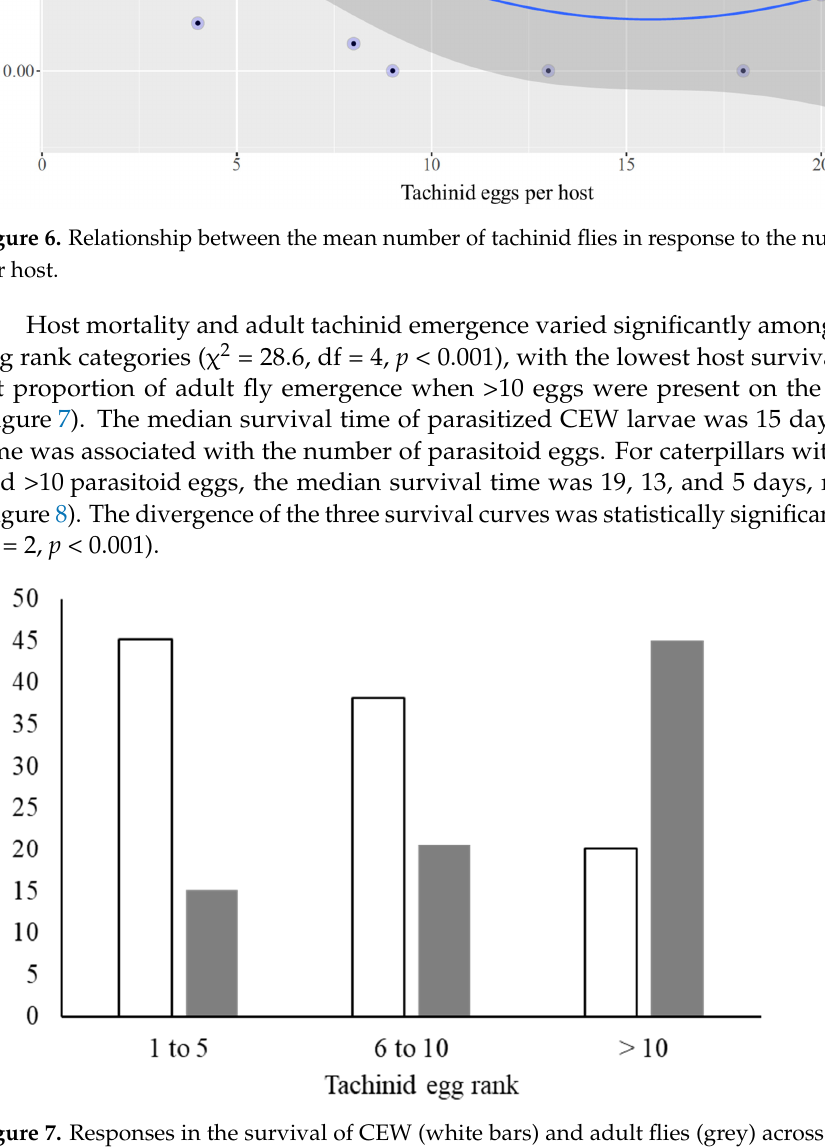
Figure 7. Responses in the survival of CEW (white bars) and adult flies (grey) across tachinid egg rank categories. Each egg category shows the percentage of successful CEW, and the proportion of adult flies emerging from the dead individuals.